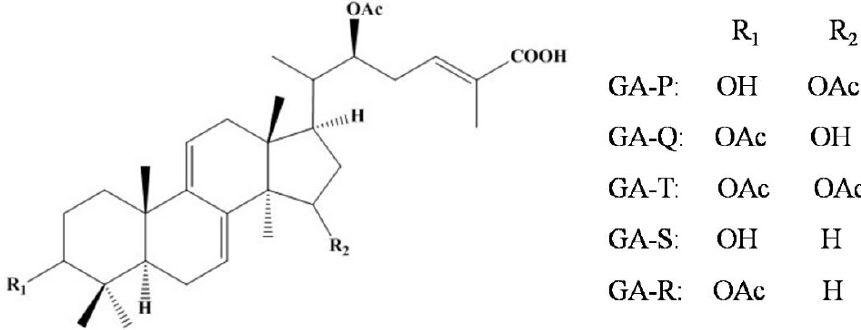
Figure 1. Structures of the five GA compounds isolated and used for content determination. Notes: OH: hydroxy group; OAc: acetoxyl group.